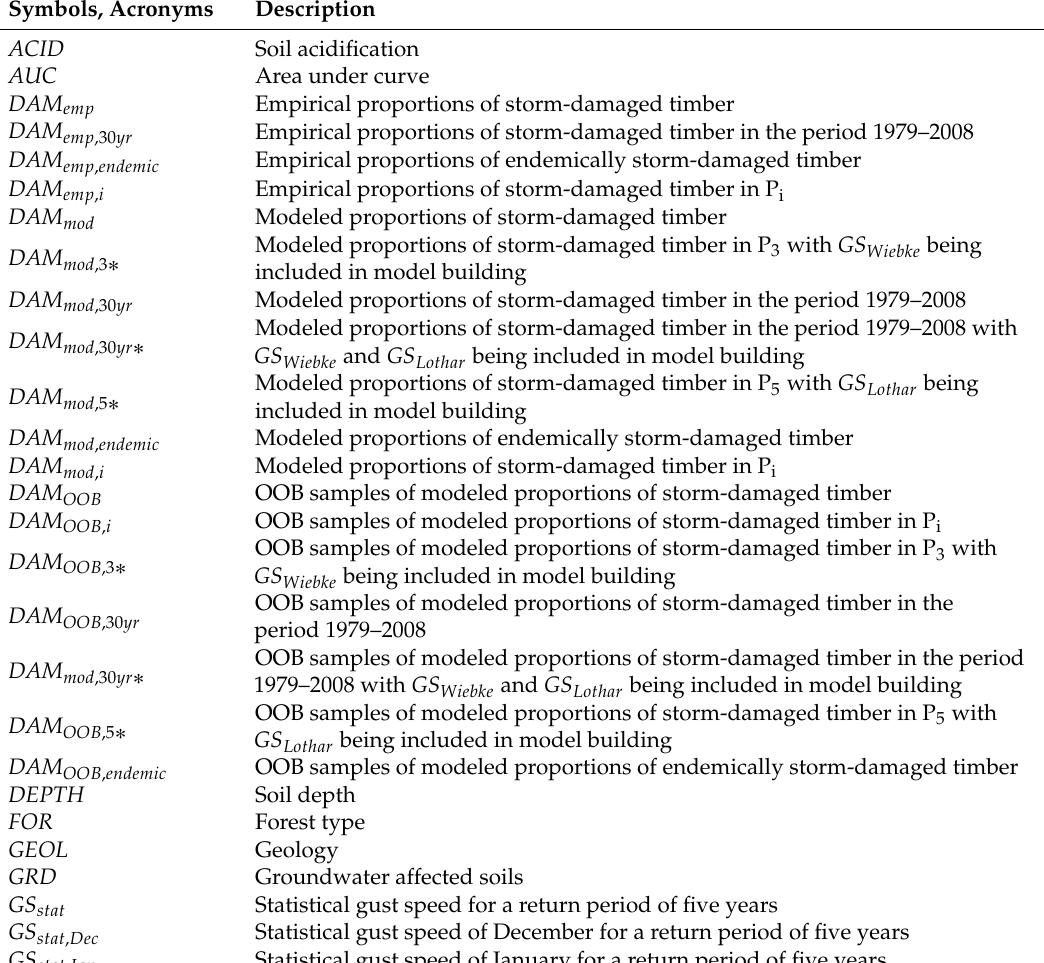
Table A1. List of symbols, abbreviations and